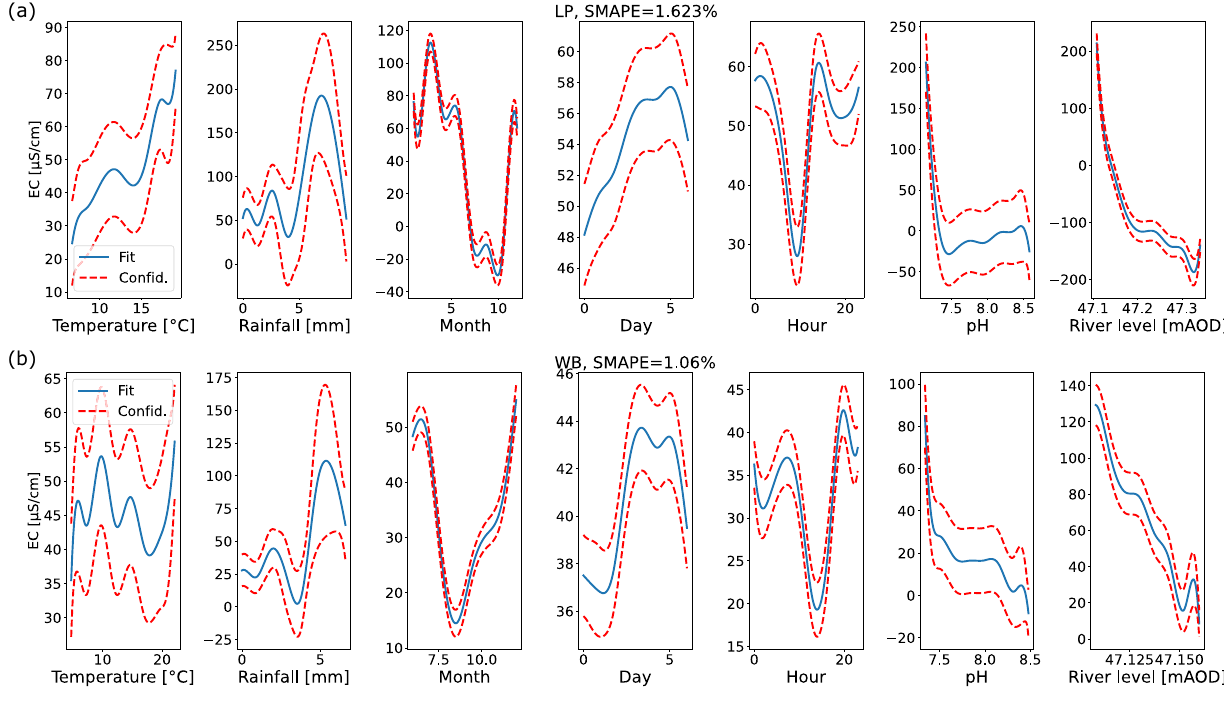
Figure 7. Results of the GAM analysis for LP ( a ) and WB ( b ). Best fitting splines of the different features x i and their influence on the electrical conductivity (EC) in the fully-fitted GAM approach. The blue curve gives the best fit and the red dashed lines envelop a single confidence interval ( 68% assuming an underlying Gaussian uncertainty). Finally, we report the symmetric mean absolute percentage error (SMAPE) 48 when the model is applied to the previously withhold test set.